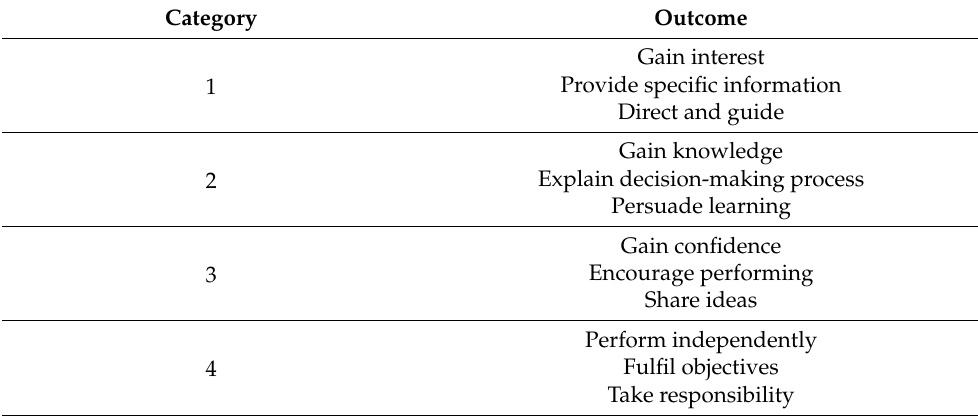
Table 5. Student learning outcomes selected for analysis in the survey.